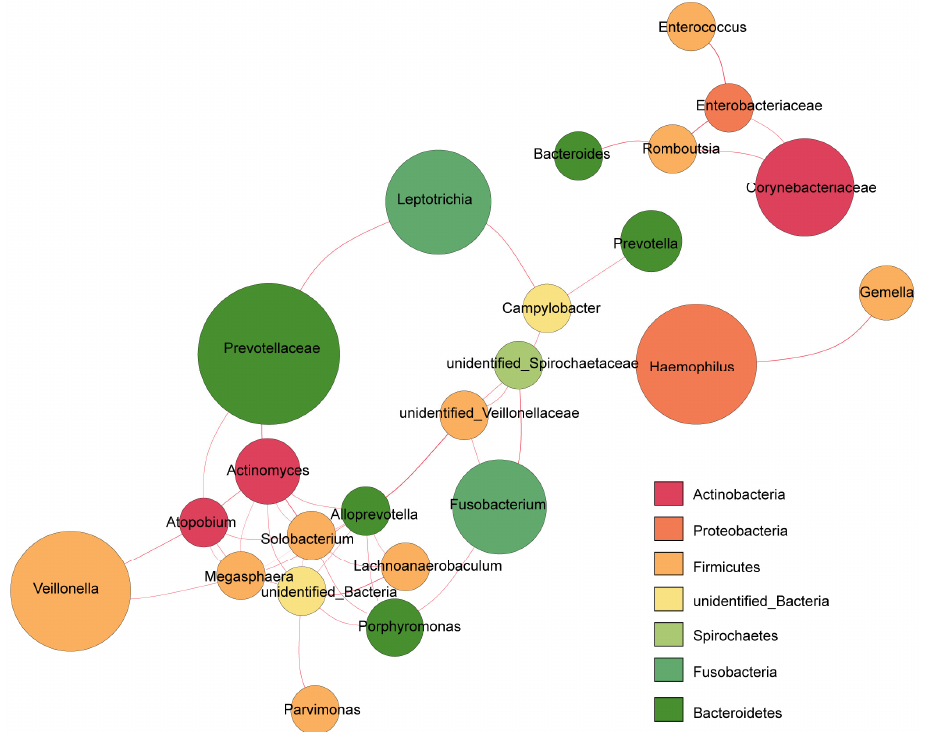
Figure 3. Network of Bacteria in FE group by Spearman rank correlation analysis. Different nodes represent different genera, the node size represents the degree of connectivity of the genus, and the same color represents the level of the same gate (as shown in the legend). The thickness of the connecting line between nodes is positively correlated with the absolute value of the correlation coefficient of species interaction. Regarding the color of the line, red represents a positive correlation.